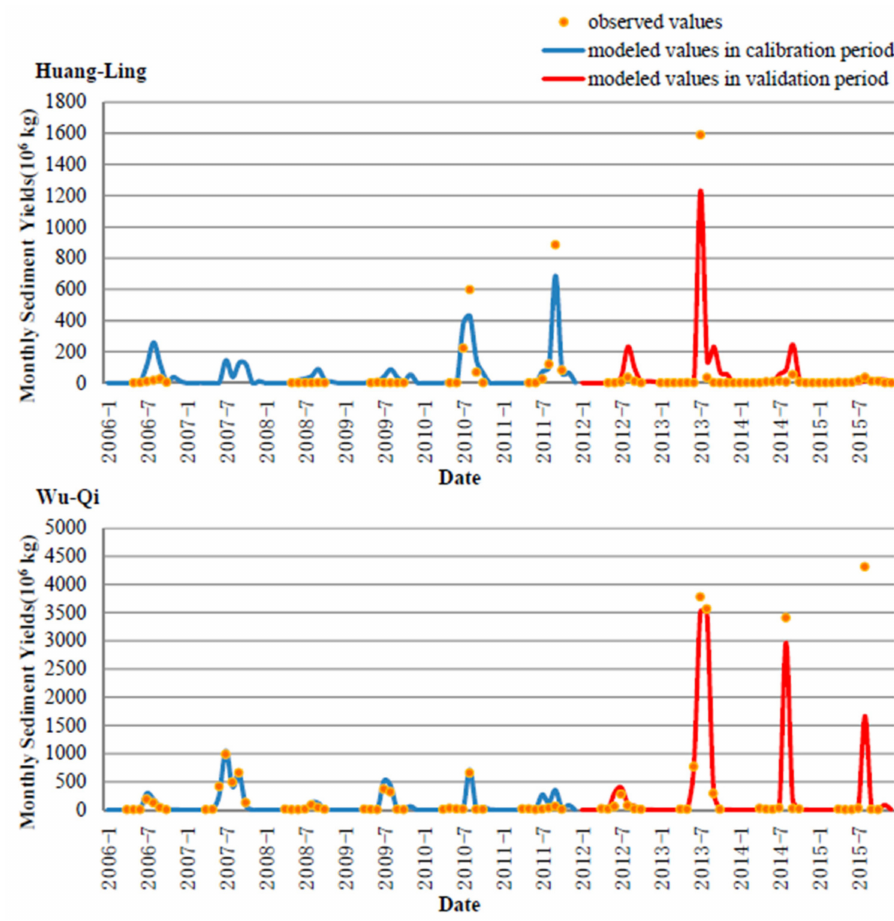
Figure 3. Time series of observed and modeled monthly sediment in the two studied